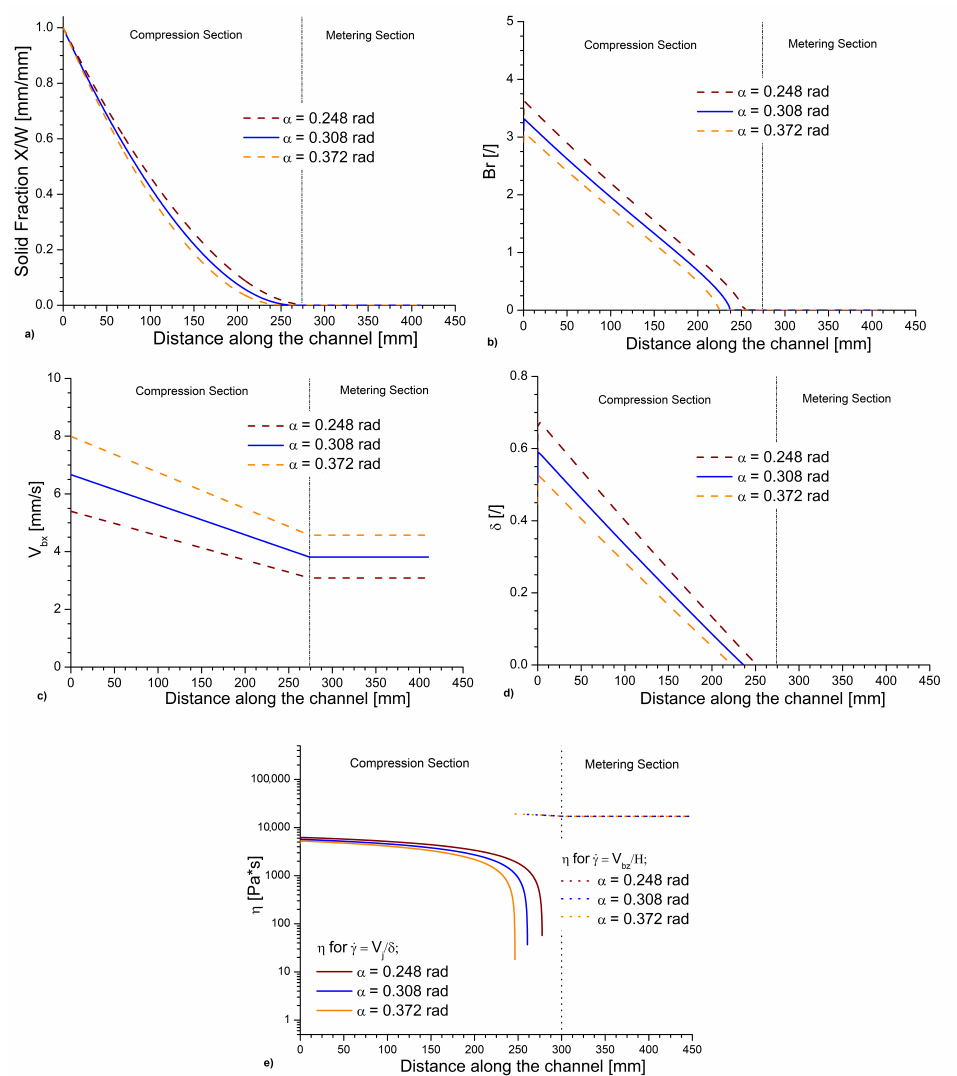
Figure 10. ( a ) Melting profile; ( b ) variation of Brinkman number; ( c ) velocity in the x direction V bx ; ( d ) melt layer thickness δ ; and ( e ) viscosity for di ff erent pitch angles considering otherwise the micro-extrusion settings and material parameters of Table 1 (Column 2). Blue (reference) lines as in Figure